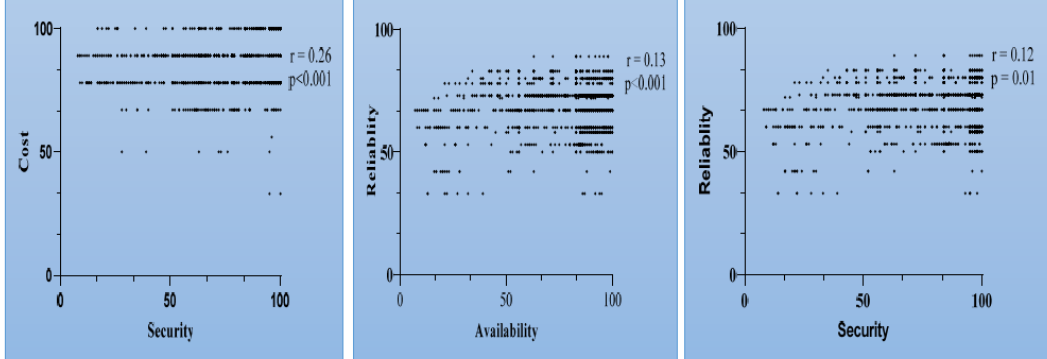
Figure 7. Correlation analyses among identified parameters using end-users’ feedback.